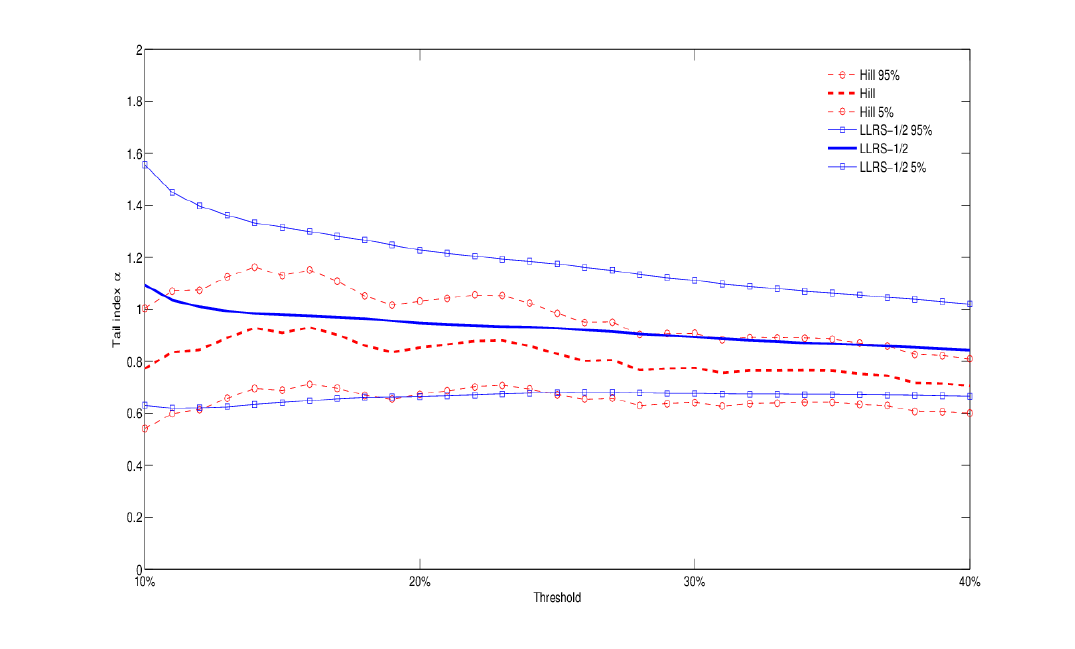
Figure 5. Occupancy level 3 types corresponding to dwellings (single family and multi family), institutional housing, condos, housing associations, : tail index estimation (both Hill and LLRS-1/2 regression methods), with 90% confidence